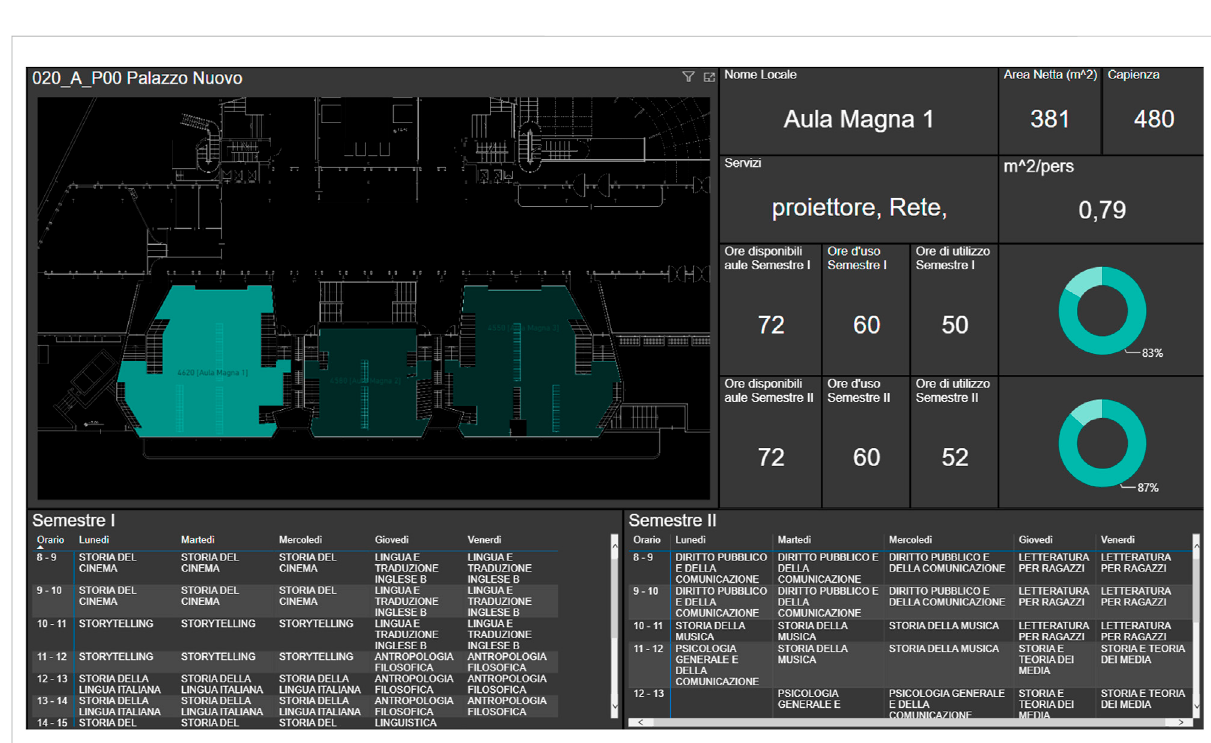
FIGURE 11 Example of space analysis dashboard for Palazzo Nuovo with hosted courses